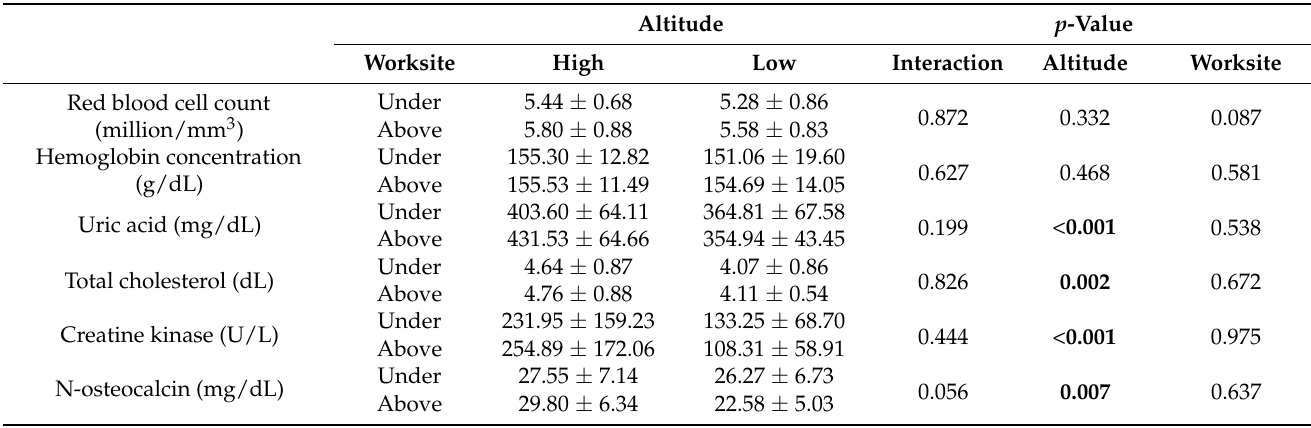
Table 4. Blood composition